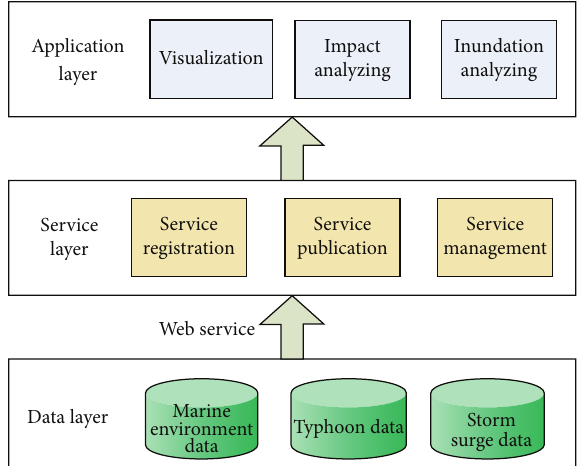
Figure 5: Framework of GVS server.